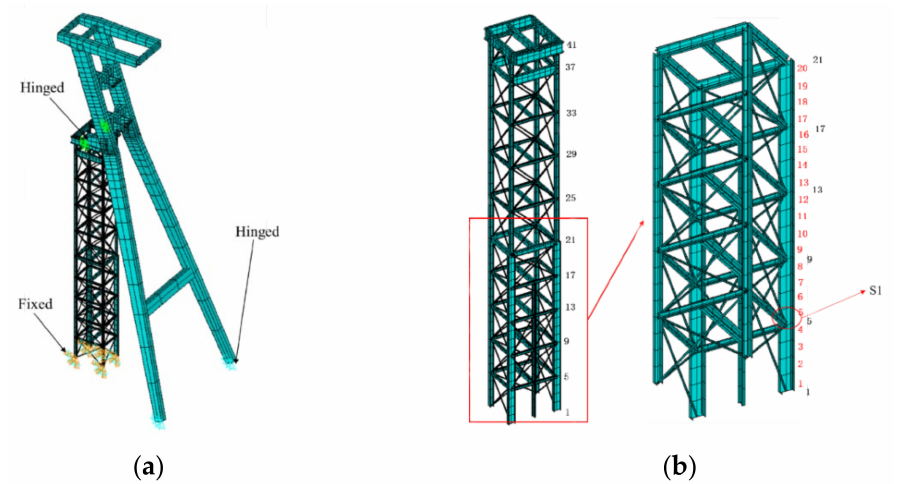
Figure 6. The finite element model and number of nodes and elements. ( a ) Finite element model of headframe; ( b ) Number of nodes and elements, the black numbers are the node numbers and the red numbers are the element